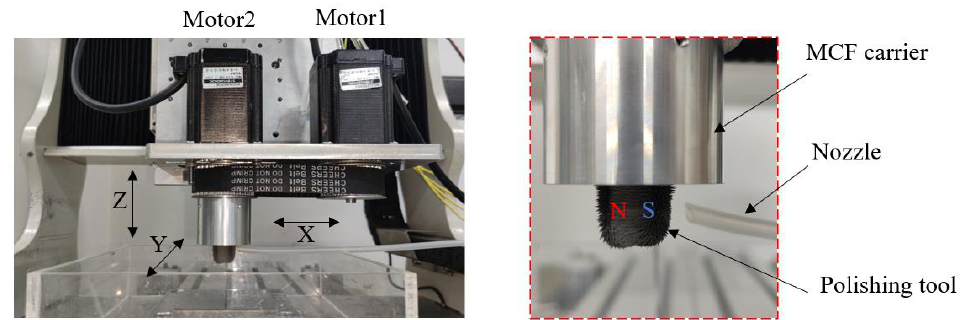
Figure 2. Experimental setup.